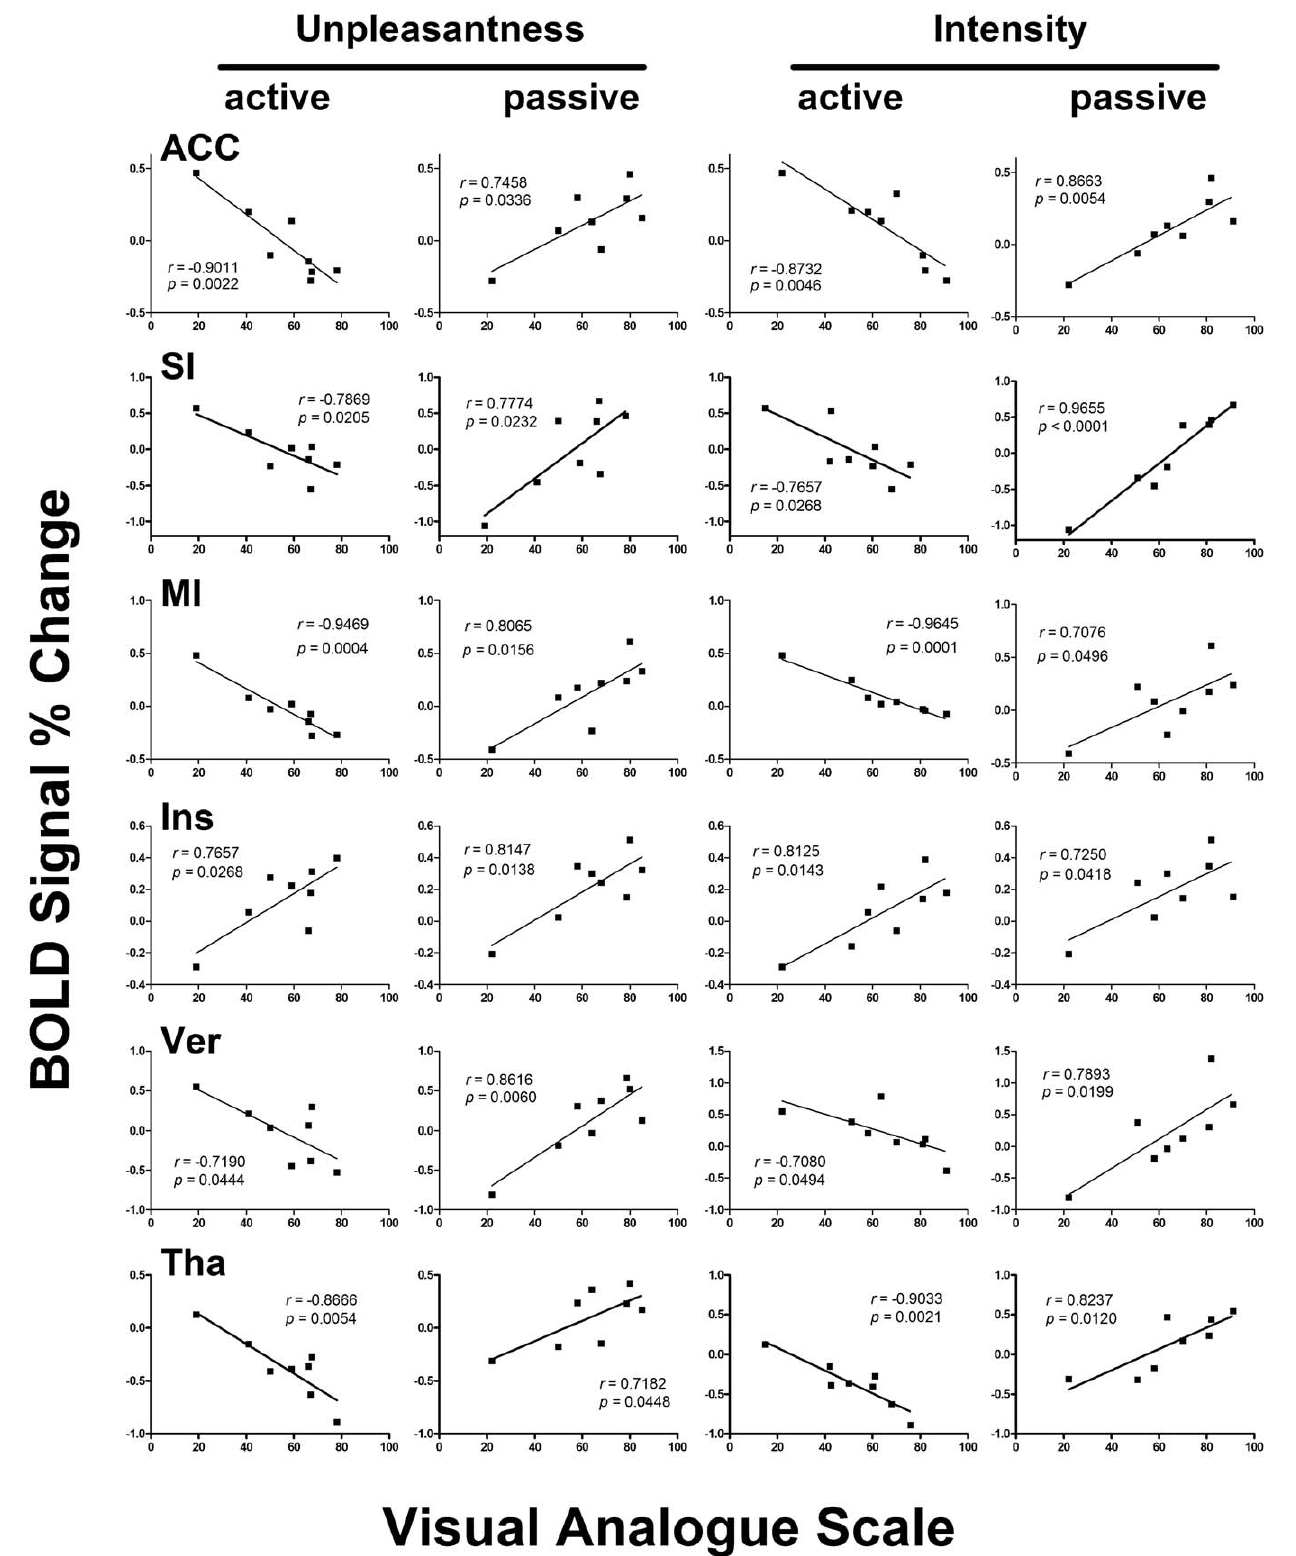
Figure 3. Correlation analysis between BOLD signal changes and pain ratings. Linear correlation analyses were performed for the BOLD signal changes in the ROIs with the unpleasantness ratings (left two columns) or pain intensity ratings (right two columns). Panels in the six rows (top to bottom) are scatter plots for the anterior cingulate cortex (ACC), the primary somatosensory cortex (SI), the primary motor cortex (MI), the insula (Ins), the vermis of cerebellum (Ver), and the thalamus (Tha). All ROIs except for the insula were negatively correlated with the ratings in active pain